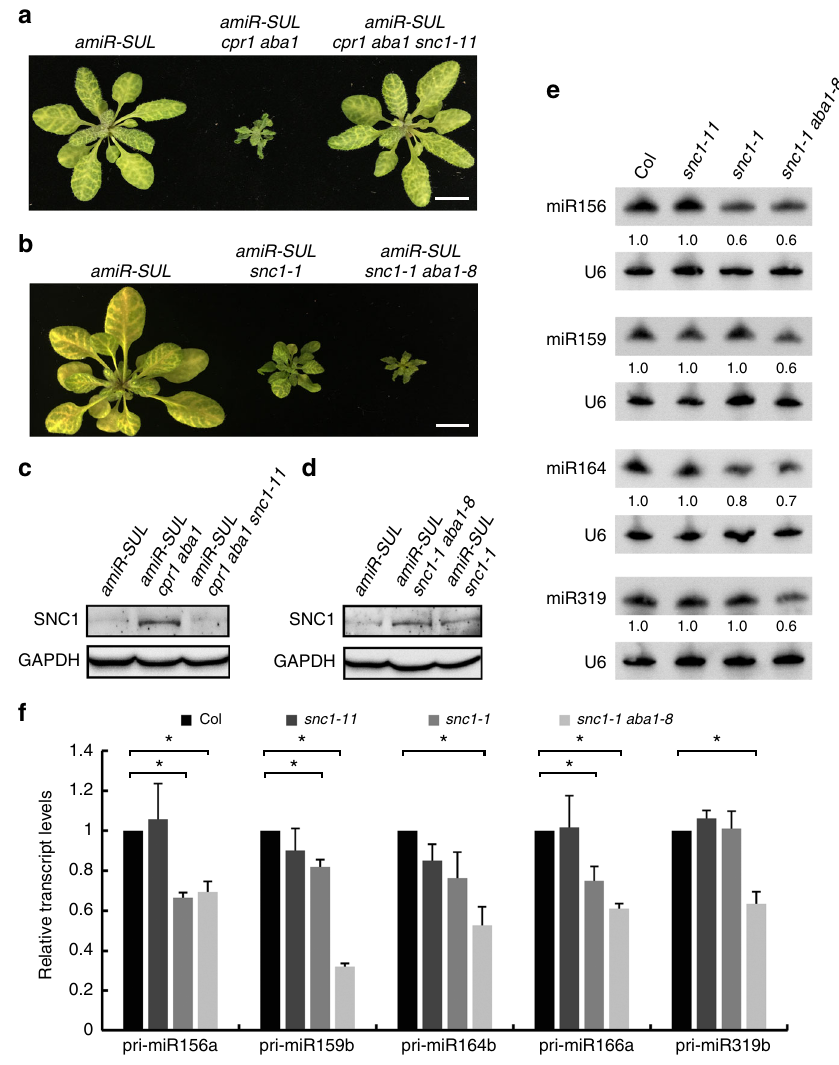
Fig. 4 The R protein SNC1 underlies the amiR-SUL suppressor phenotype of cpr1 aba1 . a Plants of the indicated genotypes. In contrast to amiR-SUL cpr1 aba1 , amiR-SUL cpr1 aba1 snc1 – 11 had the same phenotype as amiR-SUL , in terms of both plant size and leaf bleaching. Bar = 1cm. b Plants of the indicated genotypes. The amiR-SUL snc1 – 1 plants were smaller than amiR-SUL plants and showed a mild reduction in leaf bleaching. amiR-SUL snc1 – 1 aba1 – 8 plants were similar to amiR-SUL cpr1 aba1 ( a ) in both plant size and leaf bleaching. Bar = 1cm. c – d Western blots to detect the SNC1 protein in the indicated genotypes. c The SNC1 protein was drastically elevated in abundance in amiR-SUL cpr1 aba1 relative to amiR-SUL . d The SNC1 protein was elevated in abundance in amiR-SUL snc1 – 1 relative to amiR-SUL , while the levels of SNC1 were not drastically different between amiR-SUL snc1 – 1 aba1 – 8 and amiR-SUL snc1 – 1 . GAPDH served as a loading control. e Northern blots for four miRNAs from 15-day-old seedlings of wild type (Col), snc1 – 11 , snc1 – 1 and snc1 – 1 aba1 – 8 . U6 served as the loading control. The numbers indicate relative abundance. f The levels of fi ve pri-miRNAs in wild type (Col), snc1 – 11 , snc1 – 1 and snc1 – 1 aba1 – 8 as determined by real-time RT-PCR. Error bars represent standard deviation calculated from three biological replicates ( * Student ’ s t test: P <0.05). Source data are provided as a Source Data fi